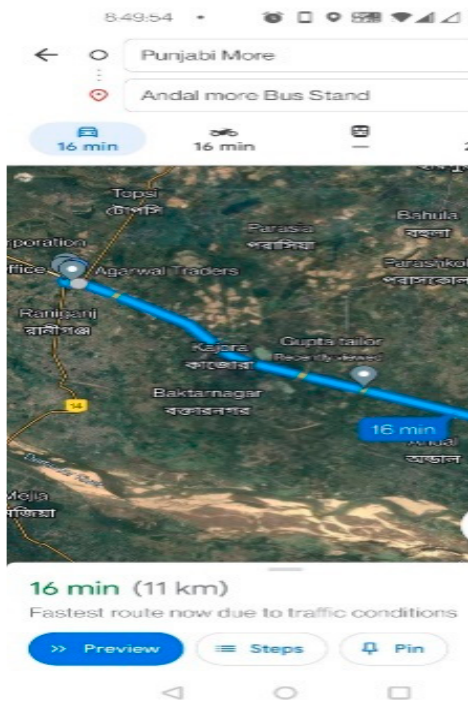
Table 6. Description of path type and distance.